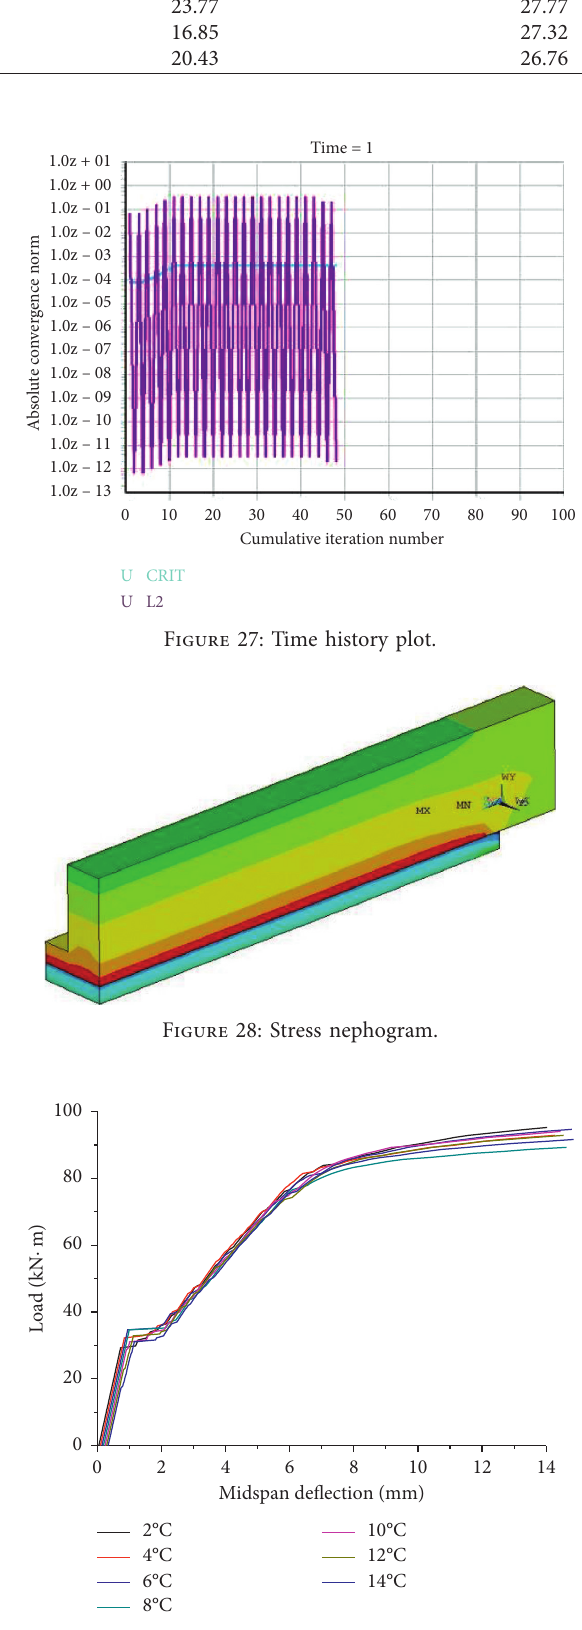
Figure 29: Load-displacement